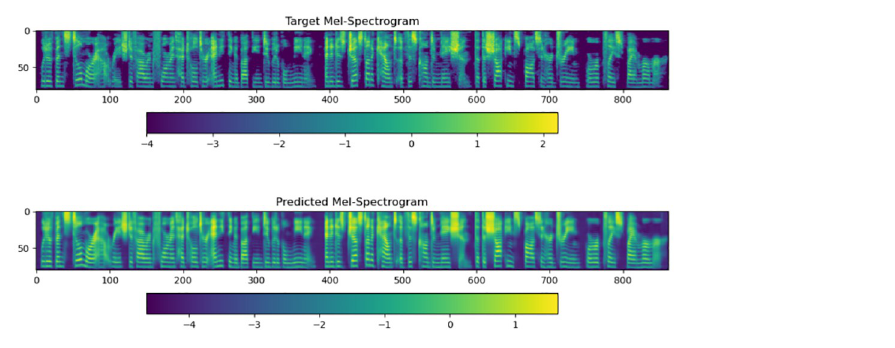
Fig 6. Iterating over 28,500 steps of the Mel-spectrogram.